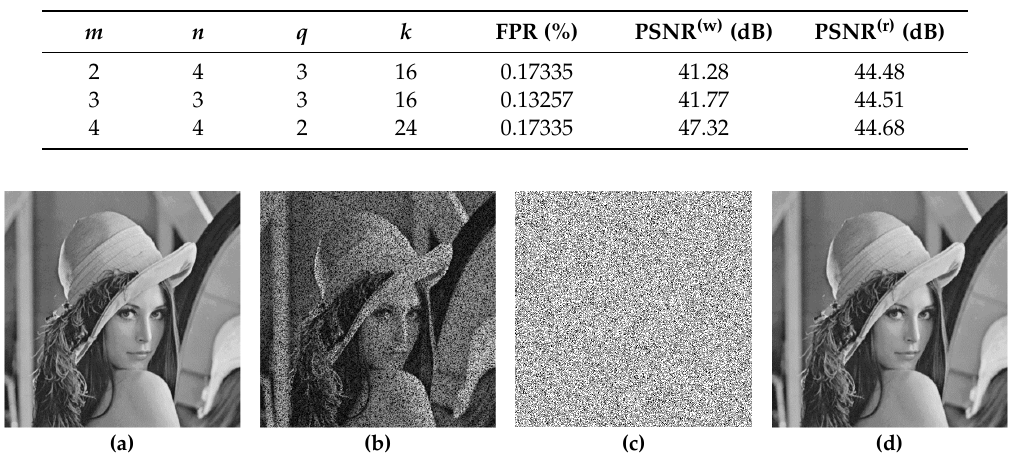
Table 2. Comparison of the average error and image quality for block-wise detection.